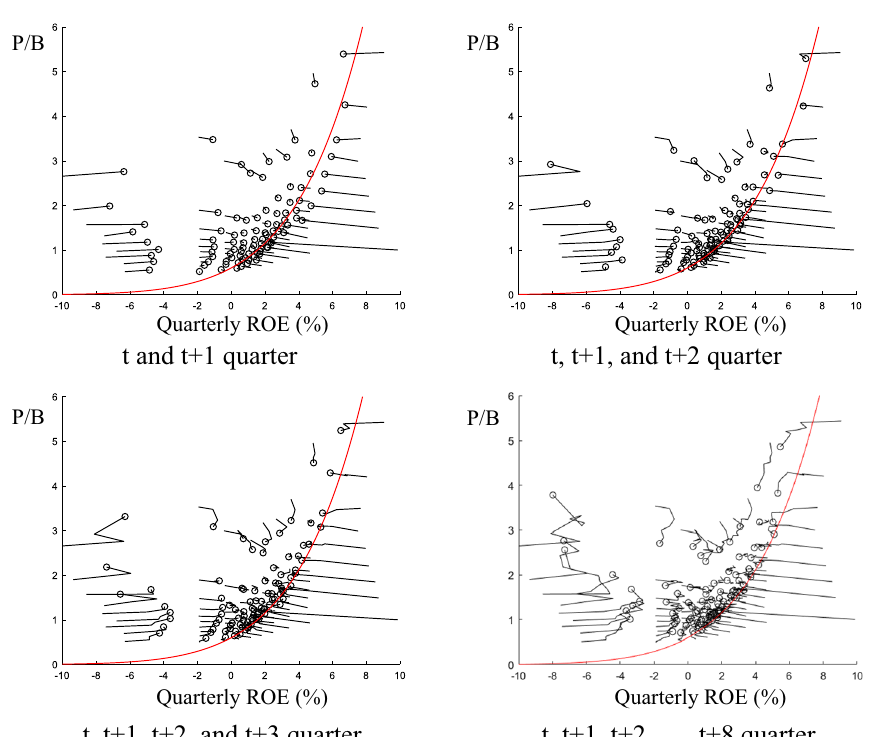
Fig. 9 The movement path of the Return on Equity (X axis) and the Price‑to‑Book value ratio (Y axis) in the current quarter and the subsequent 1, 2, 3, and 8 quarters after the portfolios being